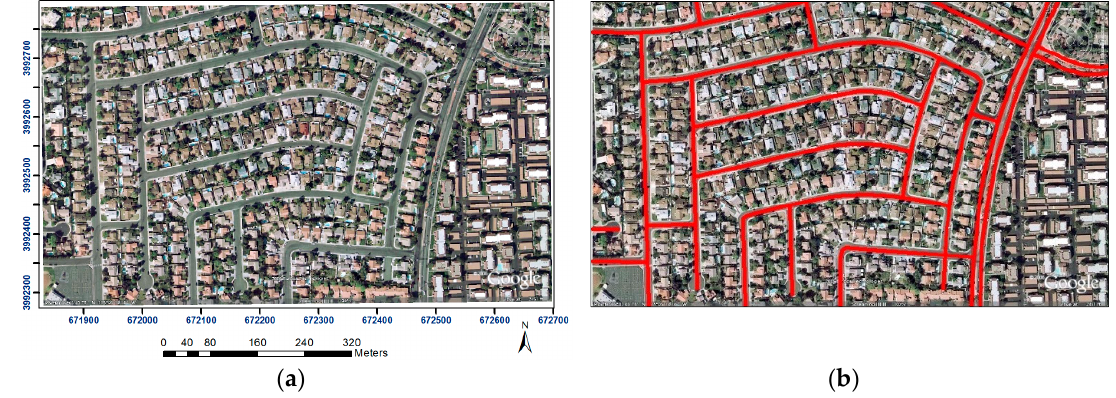
Figure 7. Second study area: ( a ) input image; ( b ) overlaid ground truth data.